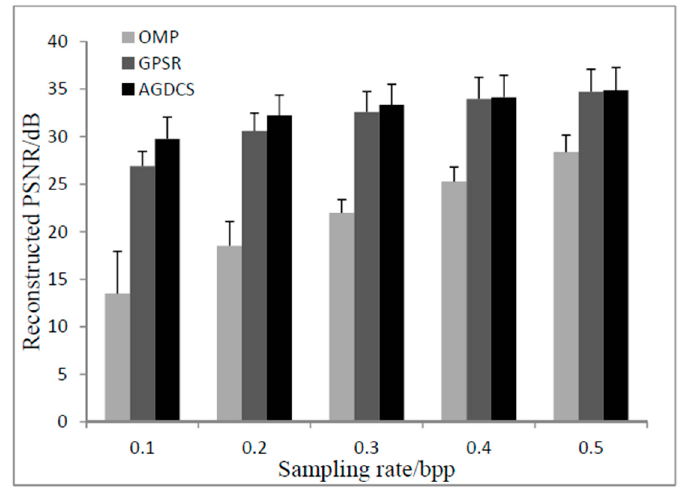
Figure 9. Comparison of the reconstructed PSNR with different reconstruction methods.